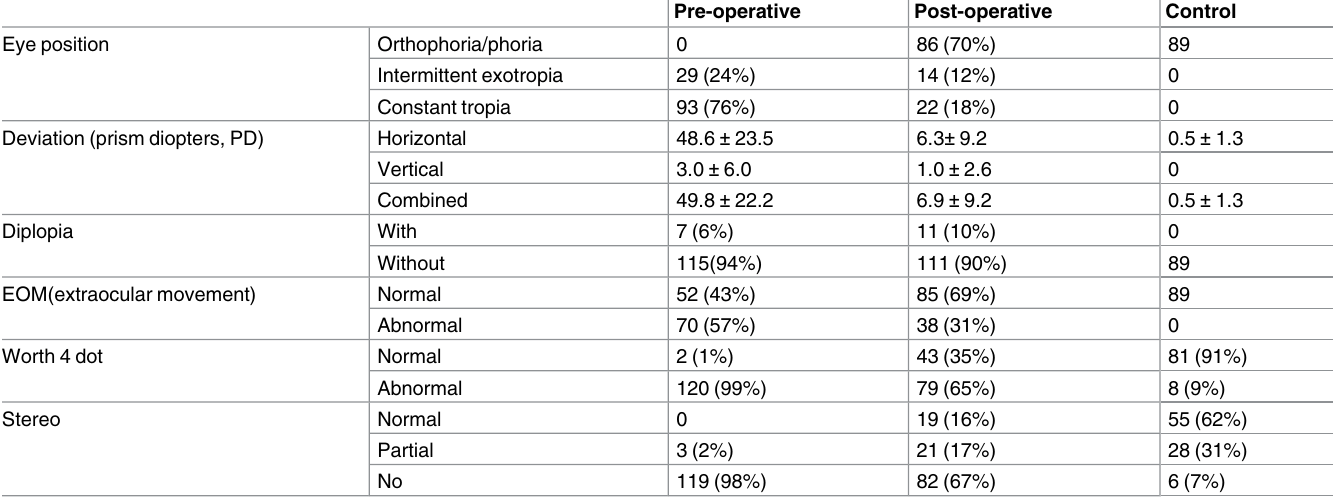
Table 3. Basic data for thepatients and